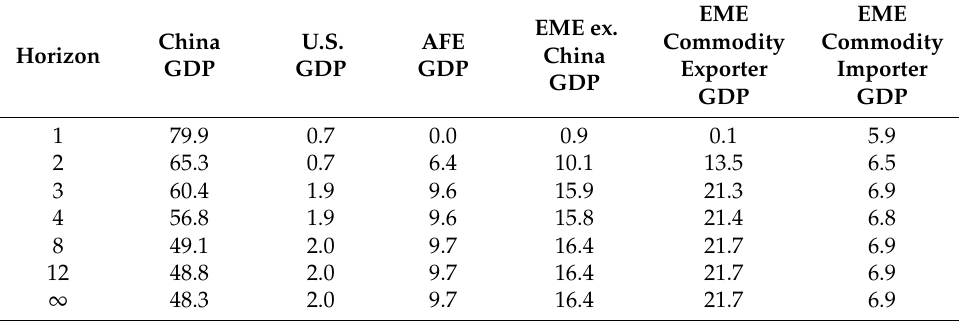
Table 7. Percent of forecast error attributable to China GDP by number of quarters.